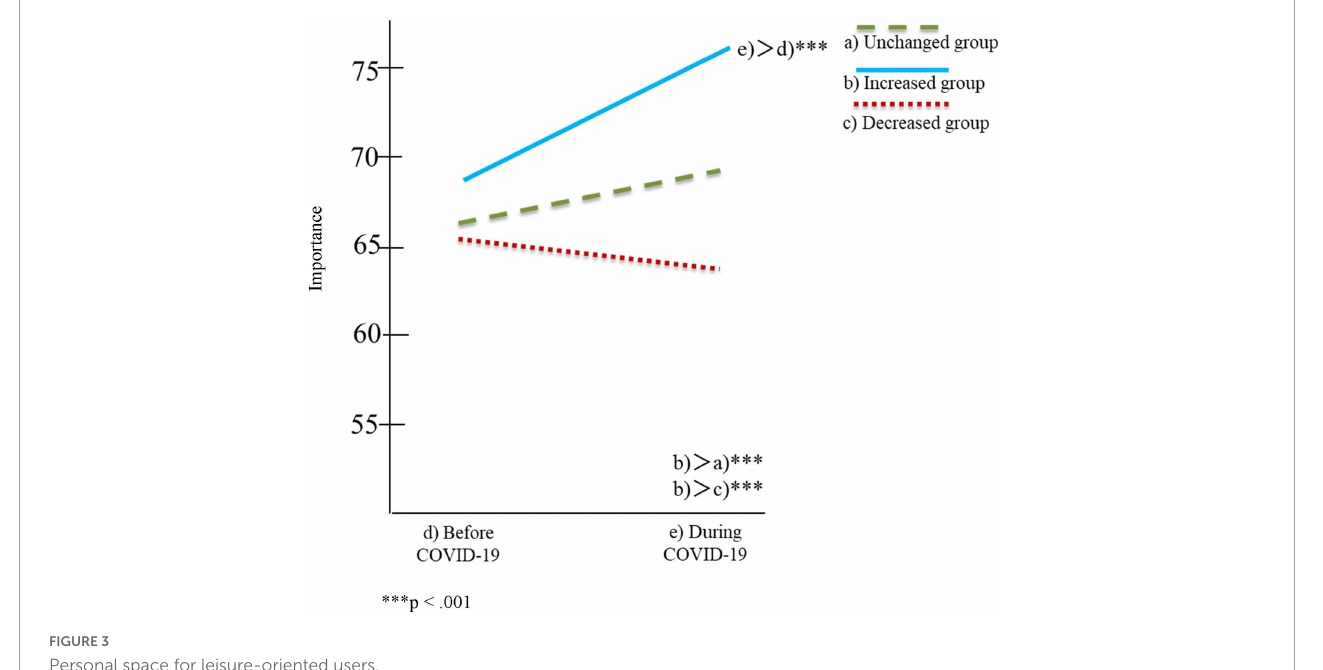
FIGURE3 Personal space for leisure-oriented users.